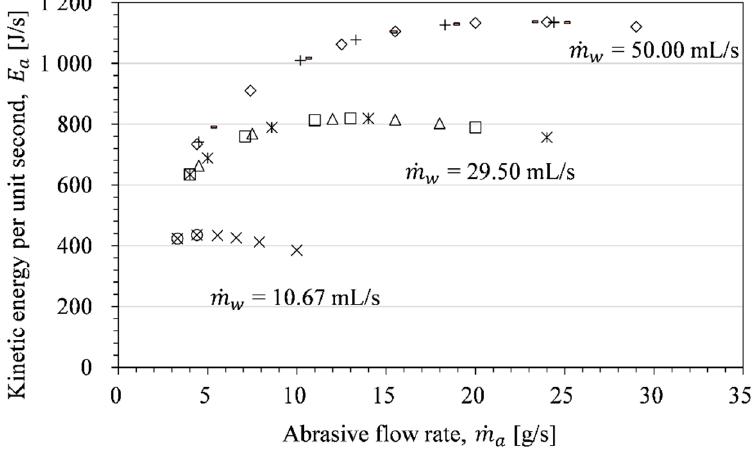
Figure 10. Abrasive waterjet kinetic energy per second as functions of the AFR and the WFR.